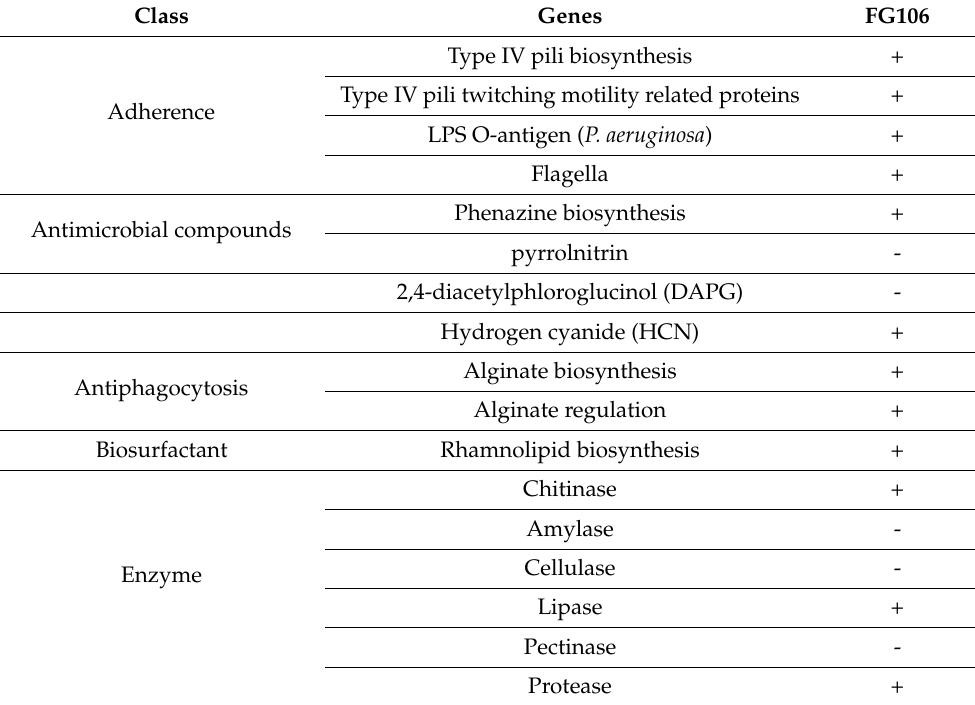
Figure 8. The draft genome was subjected to gene prediction and annotation using the RAST annotation server (Rapid Annotation using Subsystem Technology, http:/rast.nmpdr.org/ (accessed on 16 November 2021)). Table 8. Genes associated with secondary metabolite production detected in the analyzed sequences of FG106.